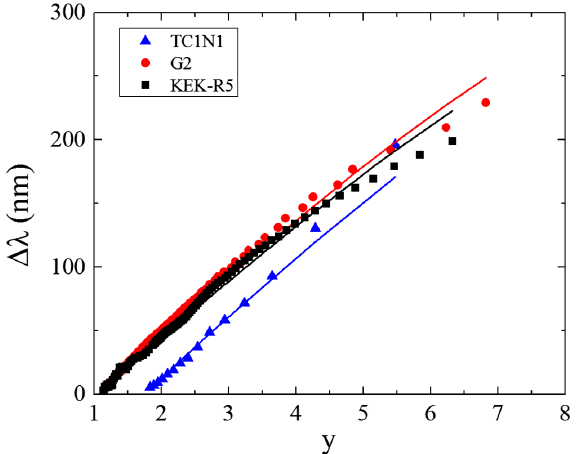
FIG. 10. Change of penetration depth as a function of the reduced temperature parameter y ¼ 1 = on cavity TC1N1 after EP, KEK-R5 after LTB and G2 after N-doping. Solid lines are fit with M-B